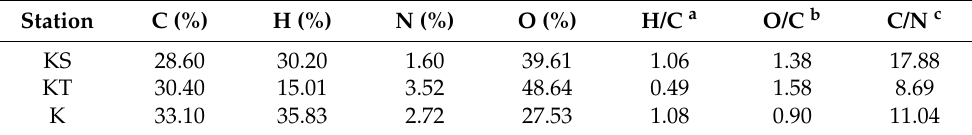
Table 3. Elemental composition and atomic of DOM extracted from three marine